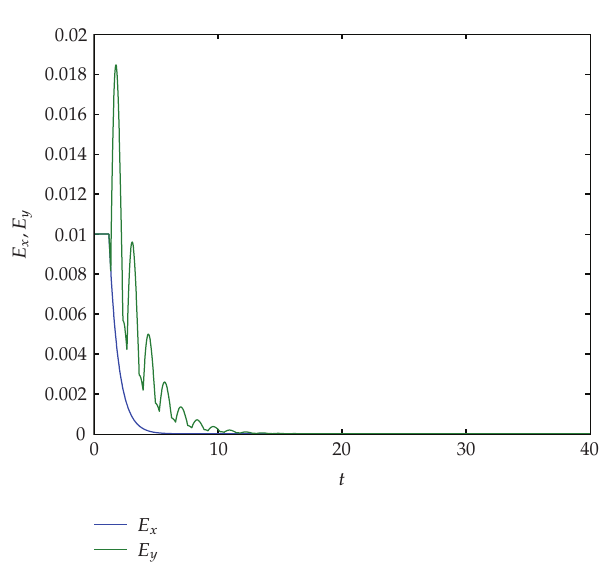
Figure 4: Inner synchronization evolution curves with globally connected topology, where N x (cid:7) 50, N y (cid:7) 100, and τ x (cid:7) τ y (cid:7) 0 . 8.